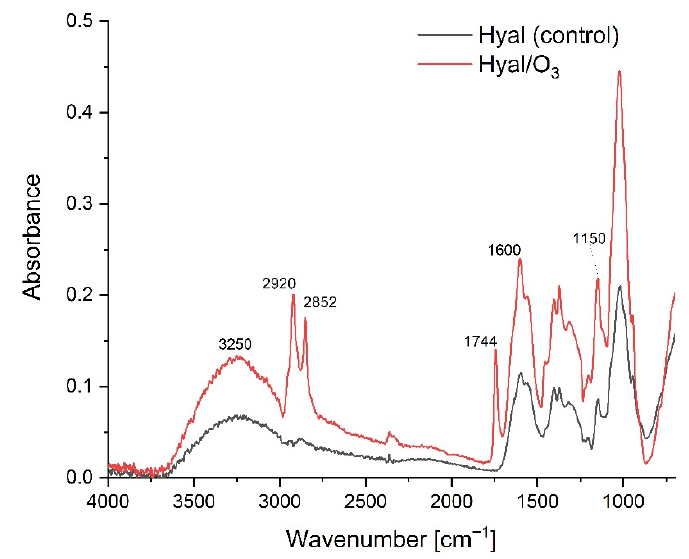
Figure 3. The FTIR-ATR spectra for the Hyal and Hyal/O 3 Figure 3. The FTIR ‐ ATR spectra for the Hyal and Hyal/O 3 films.